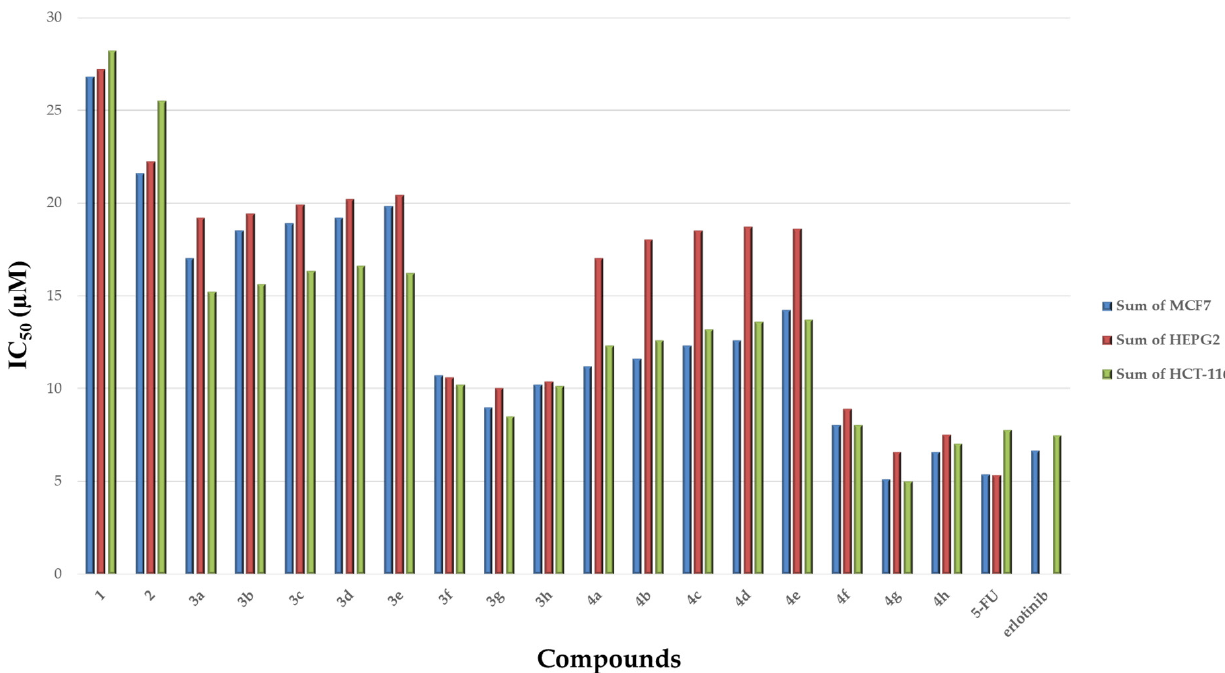
Figure 5. Cytotoxic activity (IC 50 ) of compounds 1 – 4 , 5-FU and erlotinib in different cell lines.